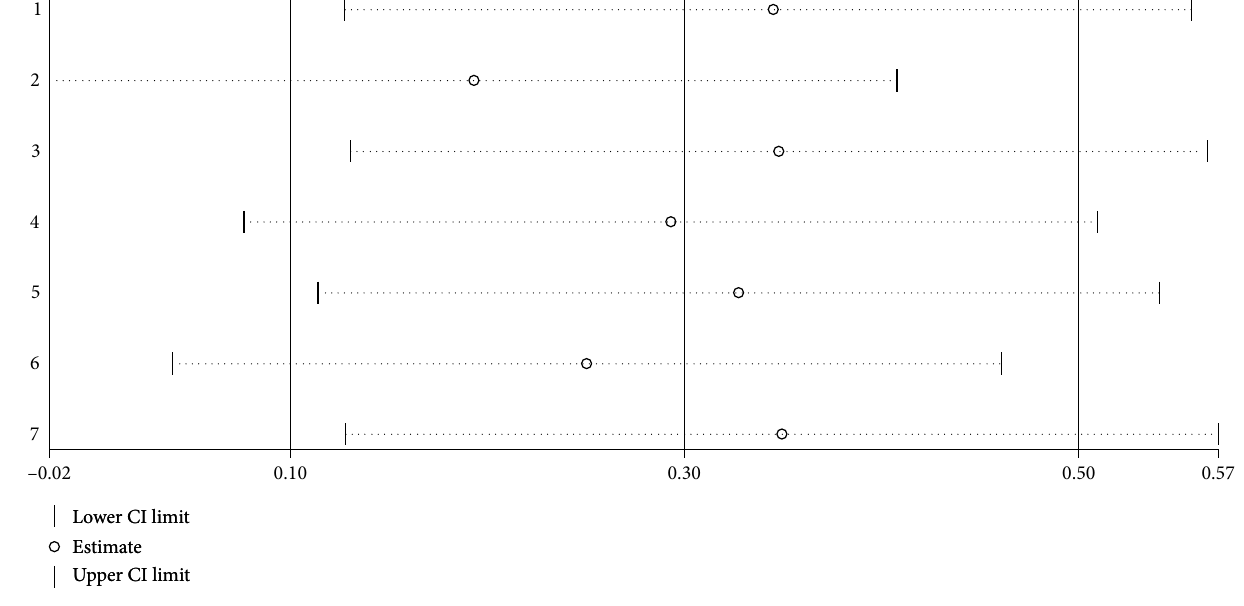
F IGURE 9: Results of the in fl uence